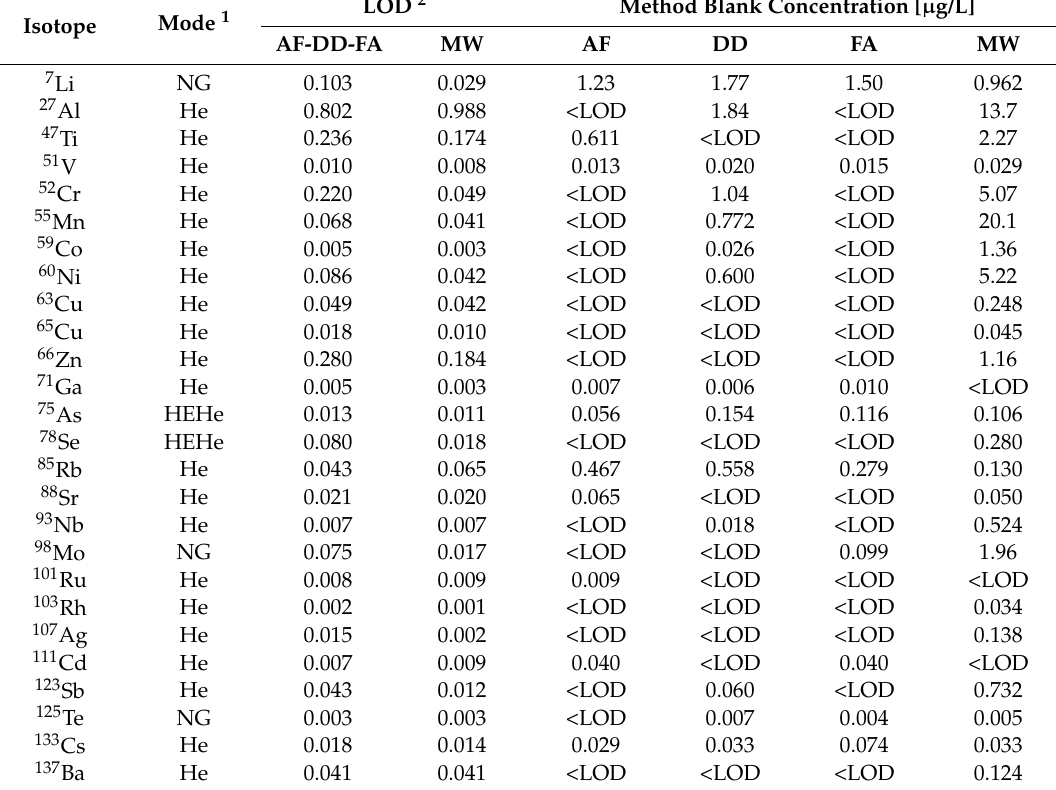
Table 1. Instrumental detection limits (LODs) and average ( n = 3) method blank concentrations of all isotopes. Values in italic are below the limit of quantitation